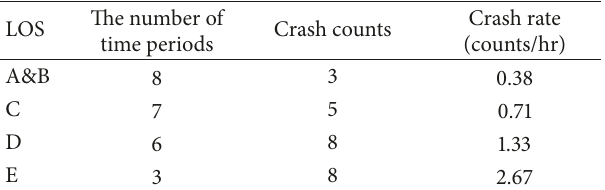
Table 2: Crash rate in the past nine years under the corresponding